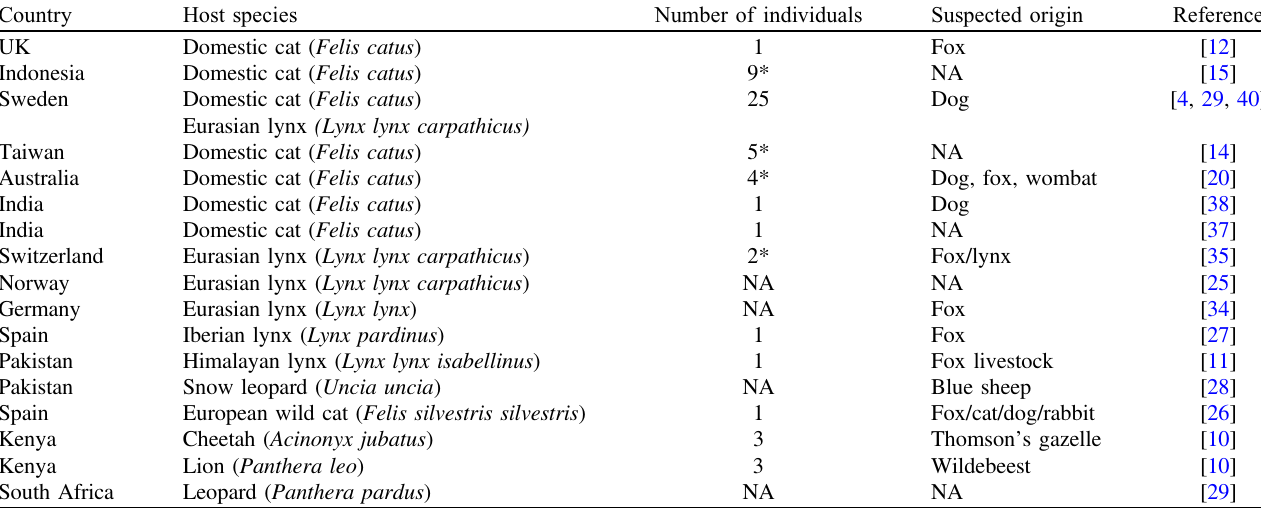
Table 1. Cases of sarcoptic mange previously reported in felids.